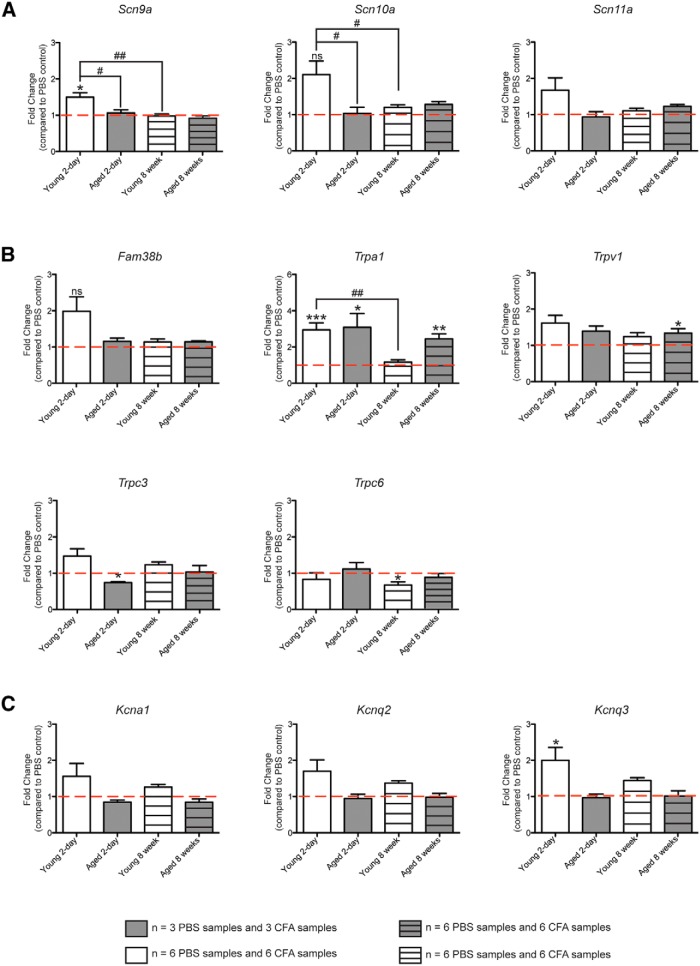
Changes in gene expression of voltage-gated and mechanosensitive ion channels do not explain the reduced action potential firing after 8 weeks of chronic inflammation. A, Gene expression for voltage-gated sodium channels NaV1.7 (Scn9a), NaV1.8 (Scn10a), and NaV1.9 (Scn11a). Bars indicate the fold change of the CFA condition over the PBS condition for each cohort. The red dotted line indicates a fold change of 1, meaning no change in expression levels between CFA and PBS conditions. *Indicates significant fold changes for the CFA vs PBS condition; #indicates significant differences in the fold change between cohorts. B, Gene expression (shown as fold change compared with PBS controls) for Piezo2 (Fam38b) and TRP channels. C, Gene expression (shown as the fold change compared with PBS controls) for voltage-gated potassium channels KV1.1 (Kcna1), KV7.2 (Kcnq2), and KV7.3 (Kcnq3).